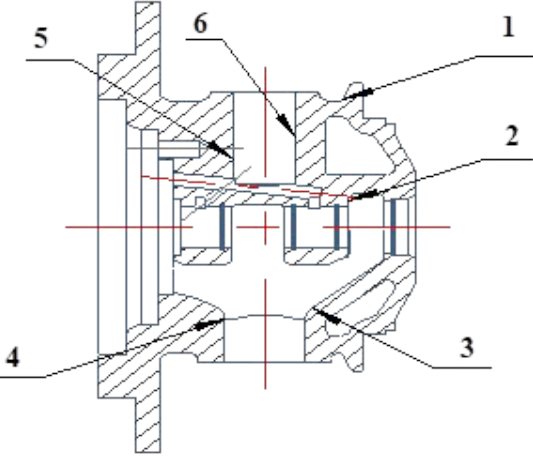
Figure 4. Temperature measuring point distribution for the